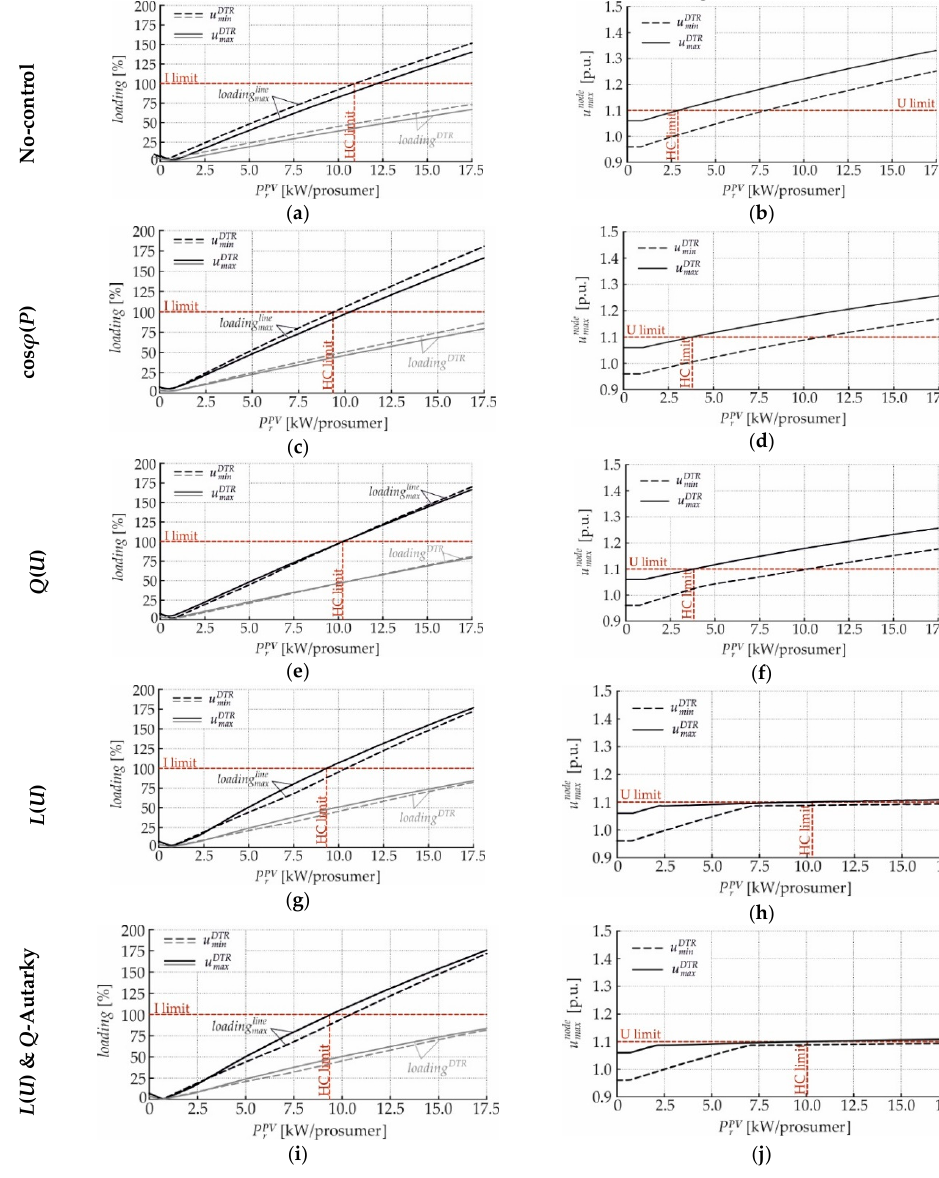
Figure 11. Current- and voltage-related hosting capacity limits of the long cable test-feeder for different control strategies: ( a , b ) no-control; ( c , d ) cos φ ( P )-control; ( e , f ) Q ( U )-control; ( g , h ) L ( U )-control; ( i , j ) L ( U )-control and Q -Autarkic prosumers.